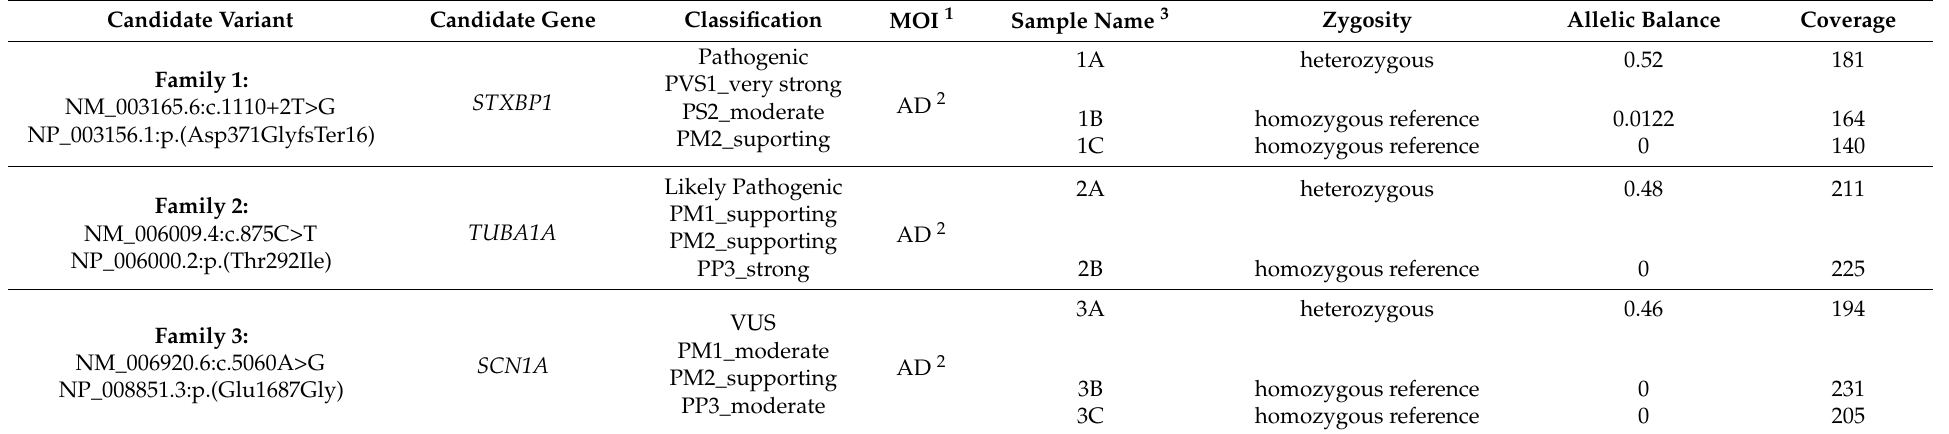
1 MOI = mode of inheritance; 2 AD = autosomal dominant; 3 Please refer to Table